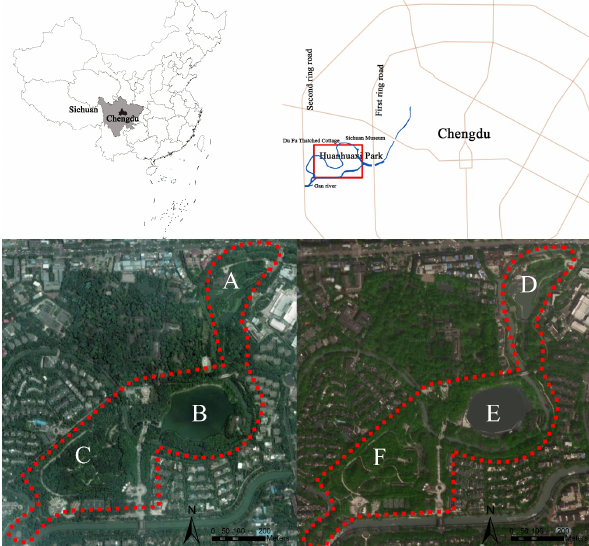
Figure 1. The images show a comparison of the park in the year 2015 and 2018 representing the park before and after the renovation: (A) Egret Island in 2015; (B) Canglang Lake in 2015; (C) Wanshu Hill in 2015; (D) Egret Island in 2018; (E) Canglang Lake in 2018; (F) Wanshu Hill in 2018.